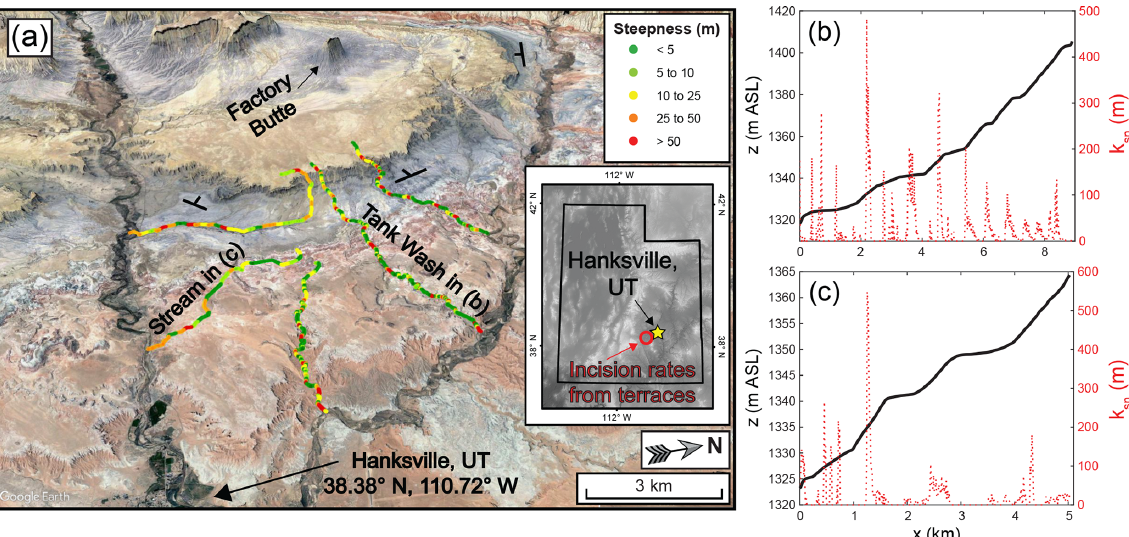
Figure 1. Hanksville, UT, is a potential example of a landscape where contact migration significantly influences channel morphology. (a) Google Earth imagery (© Google Earth) showing variations in channel steepness ( k sn using a reference concavity of 0.5) near Hanksville. These steepness values were obtained using TopoToolbox v2 (Schwanghart and Kuhn, 2010; Schwanghart and Scherler, 2014); more details regarding the extraction of profile data are available in Sect. S1. The inset shows the locations of Hanksville, UT (yellow star), and the fluvial terraces along the Fremont (red circle) that provide incision rate estimates of 0.3 to 0.85mmyr − 1 (Repka et al., 1997; Cook et al., 2009).